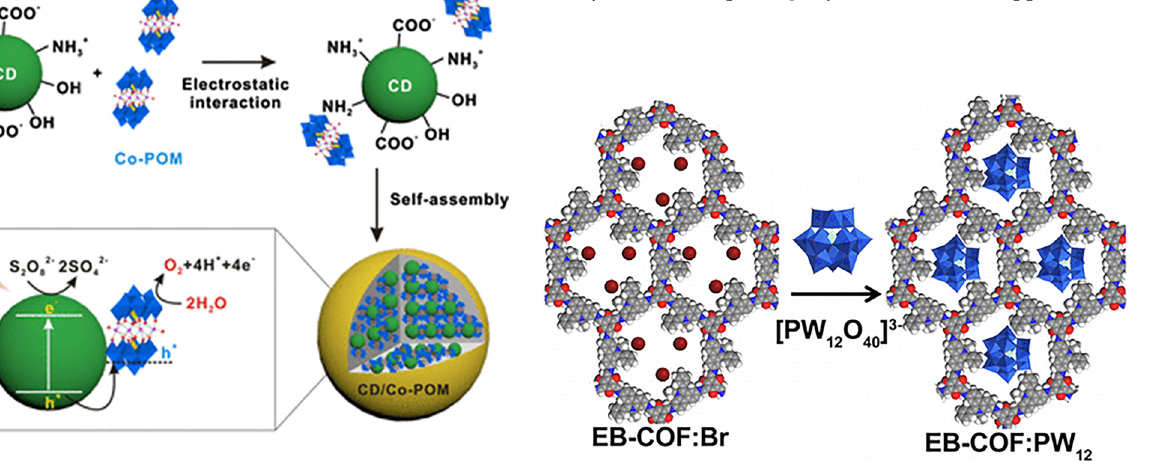
Figure 15: Encapsulation of PW 12 O 40 3 − POM in the framework of cationic COF. Adopted with permission from ref.